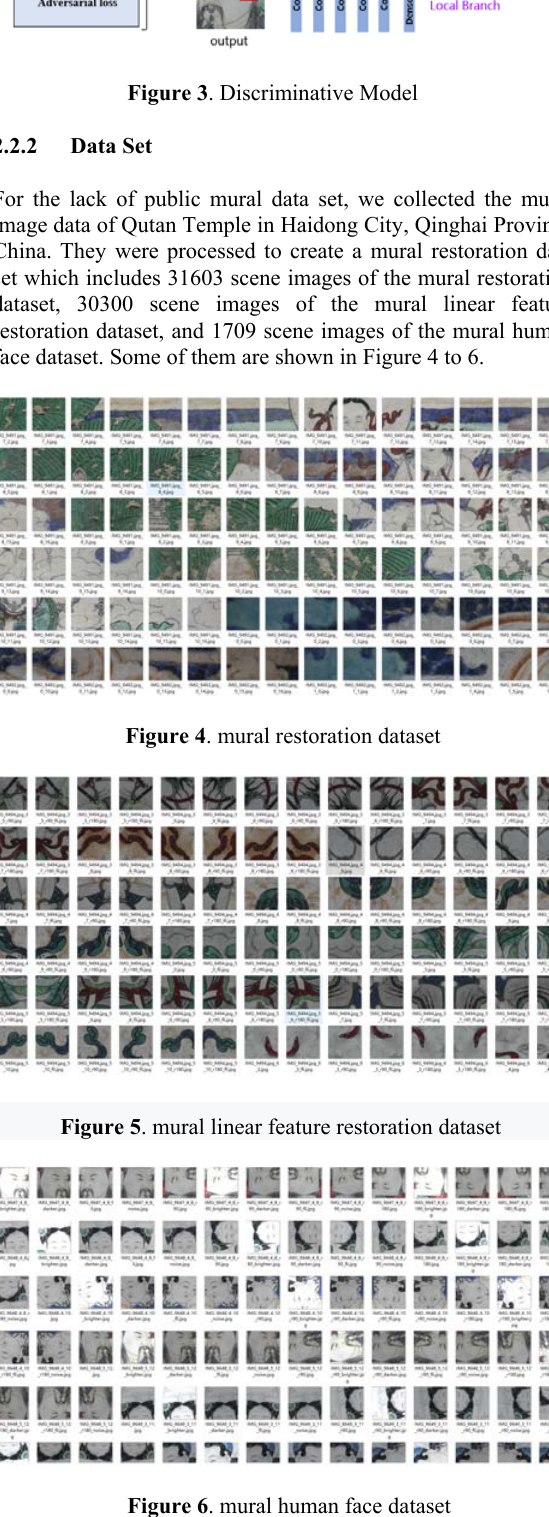
Figure 6 . mural human face